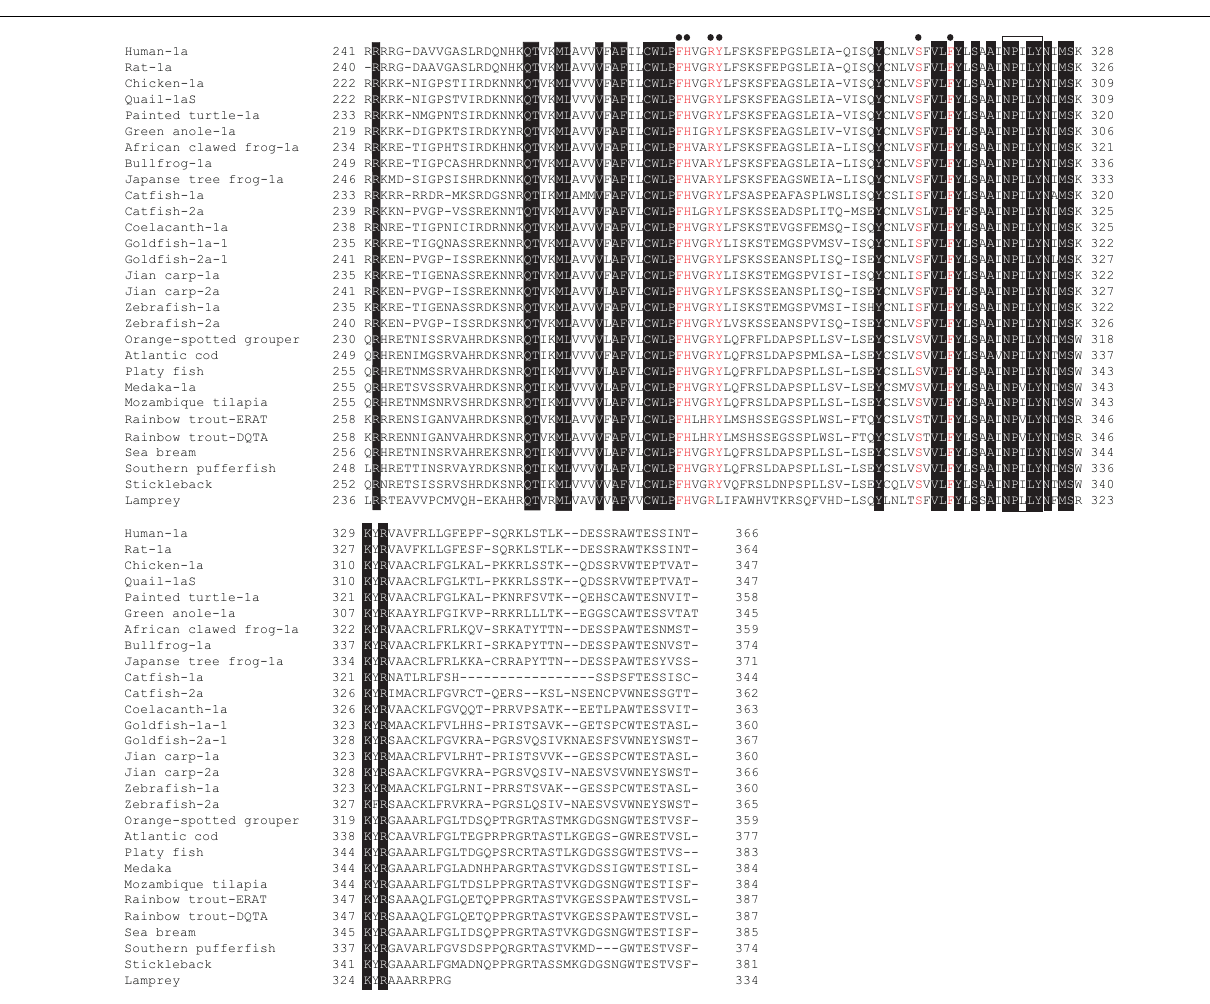
for GHS-R1a-LR. However, expression in the pituitary gland is not dominant in all species. In Mozambique tilapia, GHS-R1a-LR mRNA is mainly detected in the brain. The distribution of the ghrelin receptor in other tissues also differs among animal